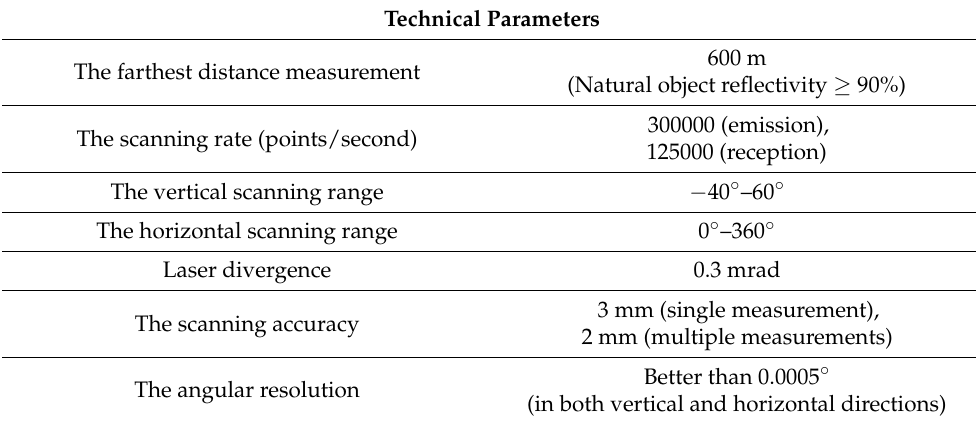
Table 1. The characteristics of RIEGL VZ-400